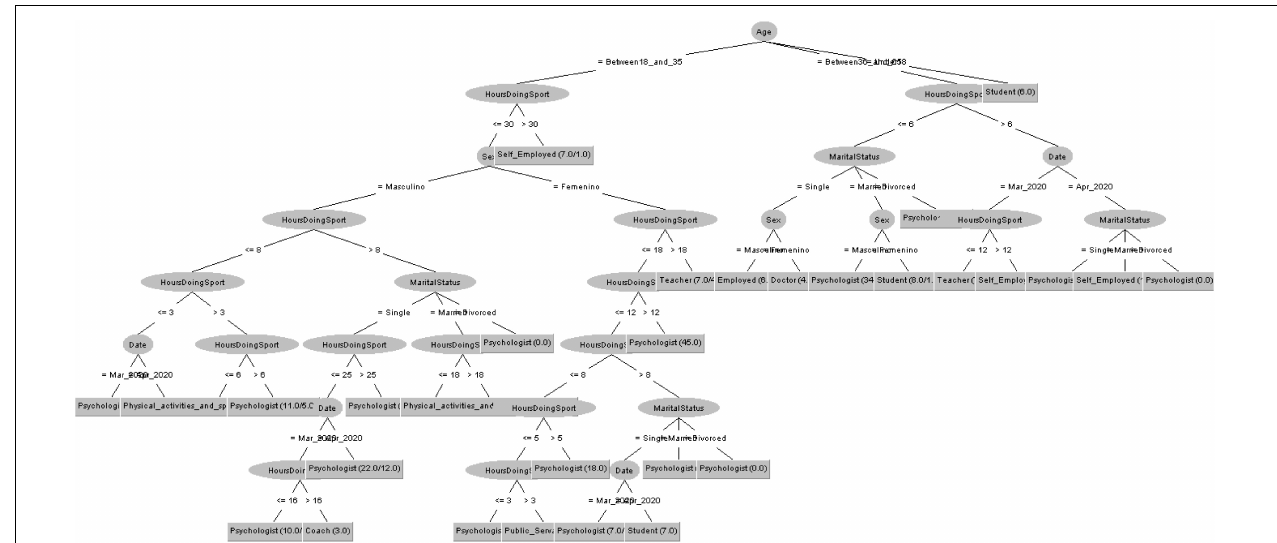
FIGURE 6 | Profession of people taking the CSAI-2 questionnaire in 2020 decision tree.